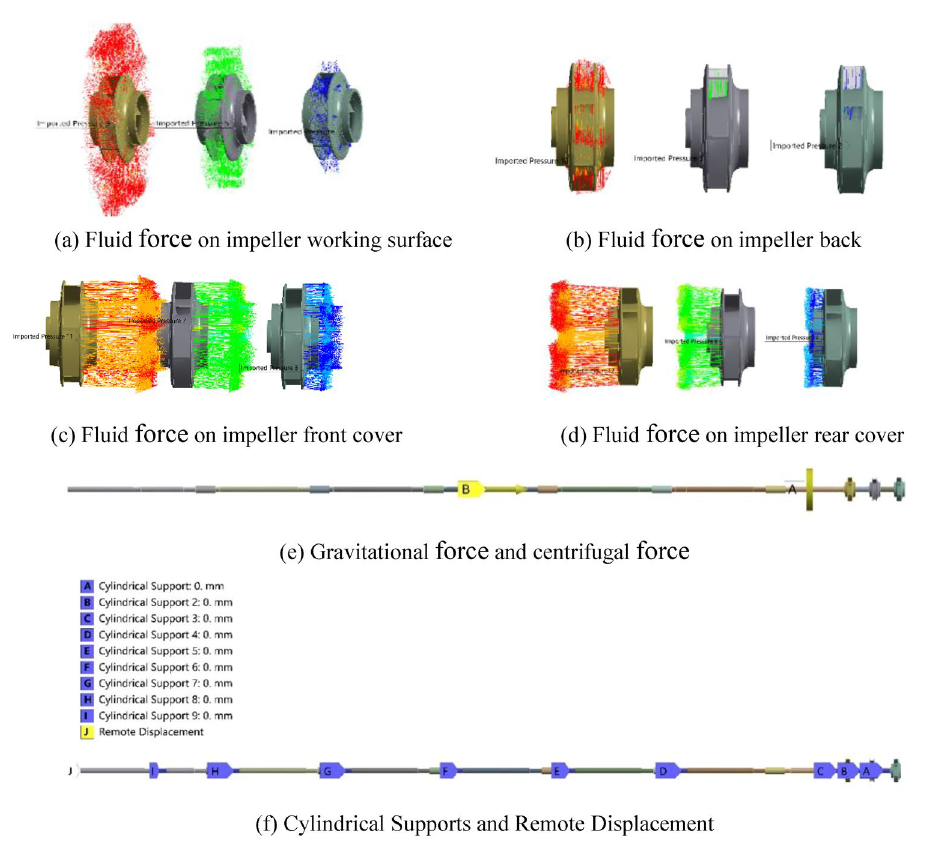
Figure 10. Setting of the boundary